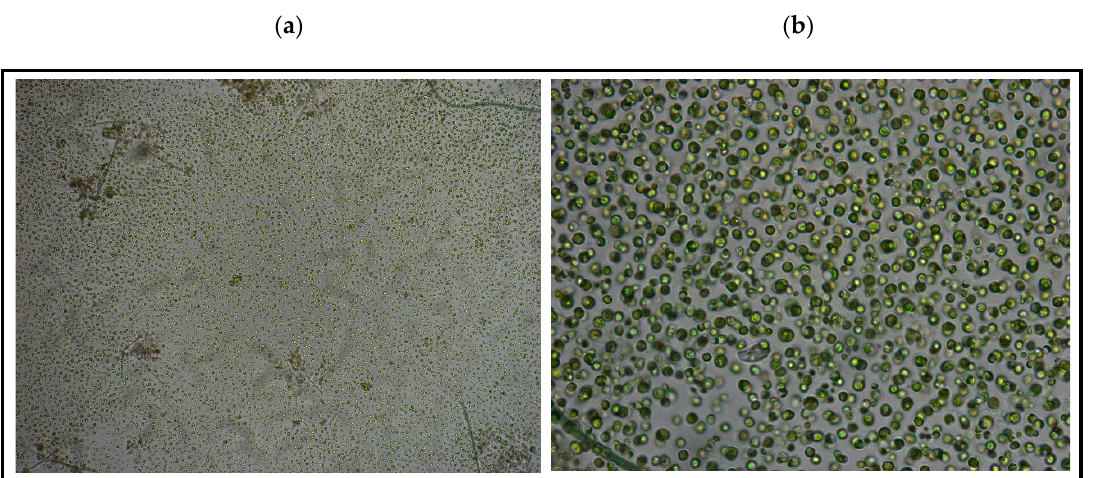
Figure 8. Chlorella sp. biomass at the beginning of the experimental cycle with microscopic magnification ( a ) ×10, ( b ) ×100.